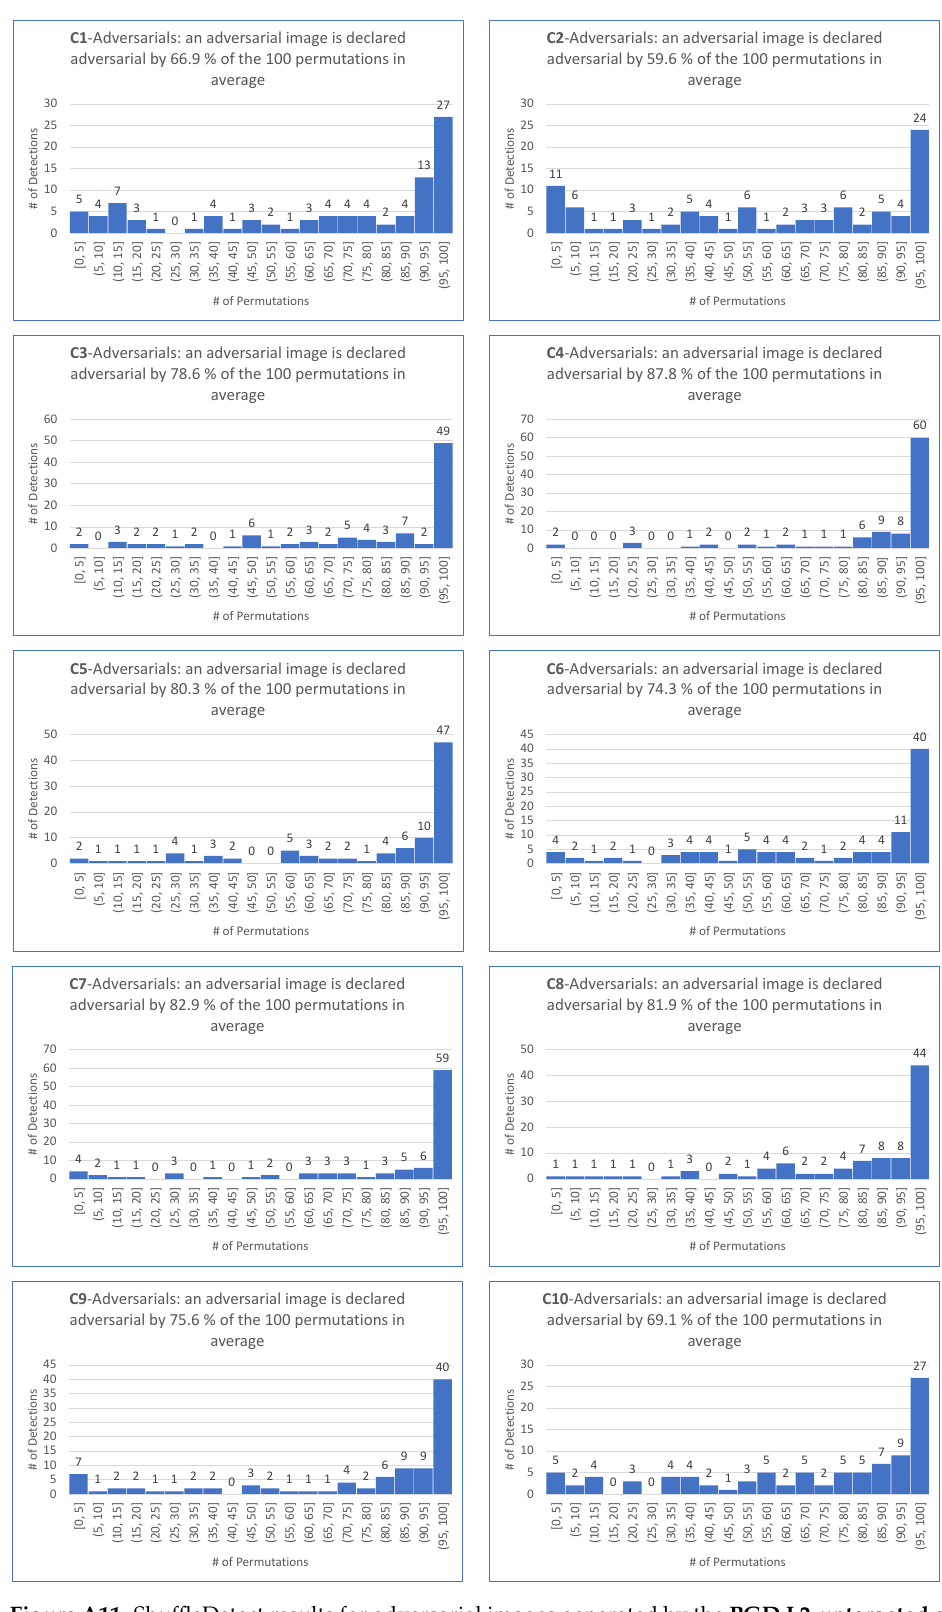
Figure A11. ShuffleDetect results for adversarial images generated by the PGD L2-untargeted attack on C = C for 1 ≤ k ≤ 10 over 100